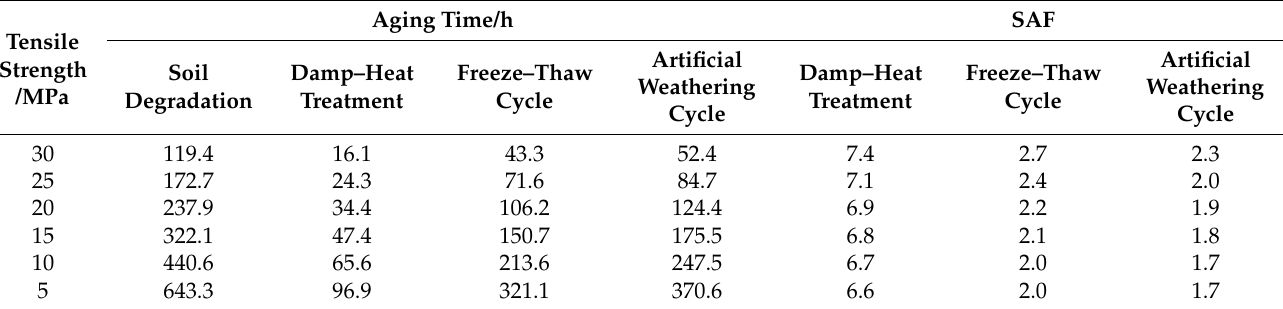
Table 3. Relationship between soil burial degradation and accelerated aging methods.